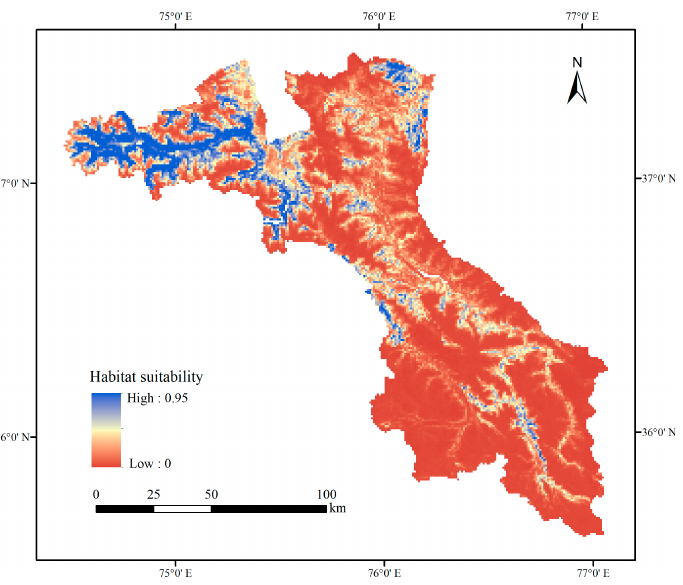
Figure 2. The current habitat suitability of Siberian ibex in Taxkorgan Nature